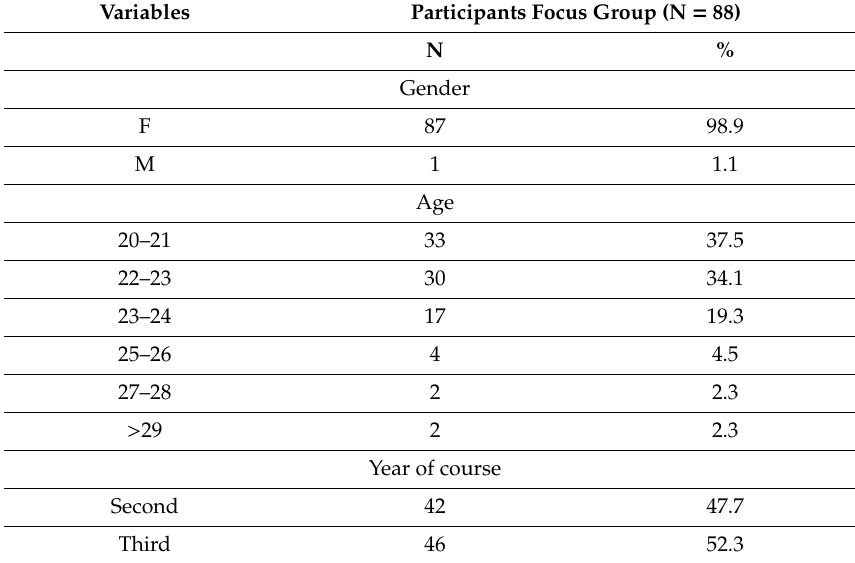
Table 2. Characteristics of the participants of focus groups [student n = 88] and of meeting between senior midwives [expert midwife n =